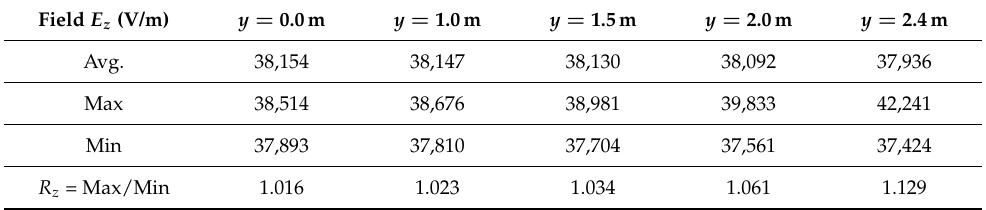
Table 2. Field variations in the TPC for the single-anode design with 42 voltage strips. Field E z